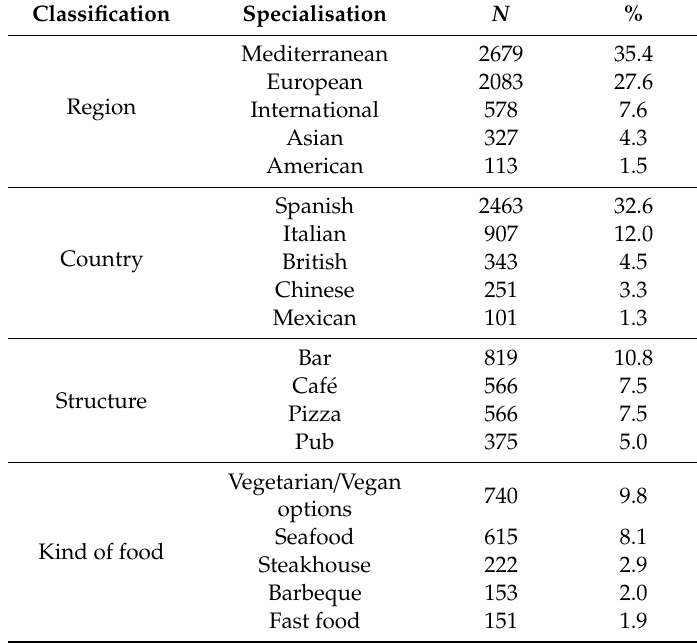
Table 7. More frequent specialisation of establishments serving food in the Canary